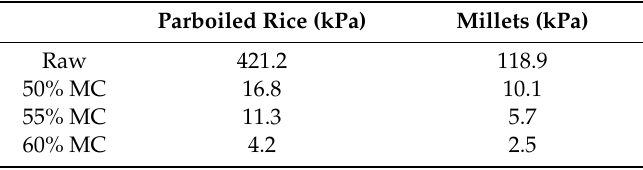
Table 1. Young’s modulus of raw and autoclaved parboiled rice and millet at di ff erent moisture contents. Parboiled Rice (kPa)